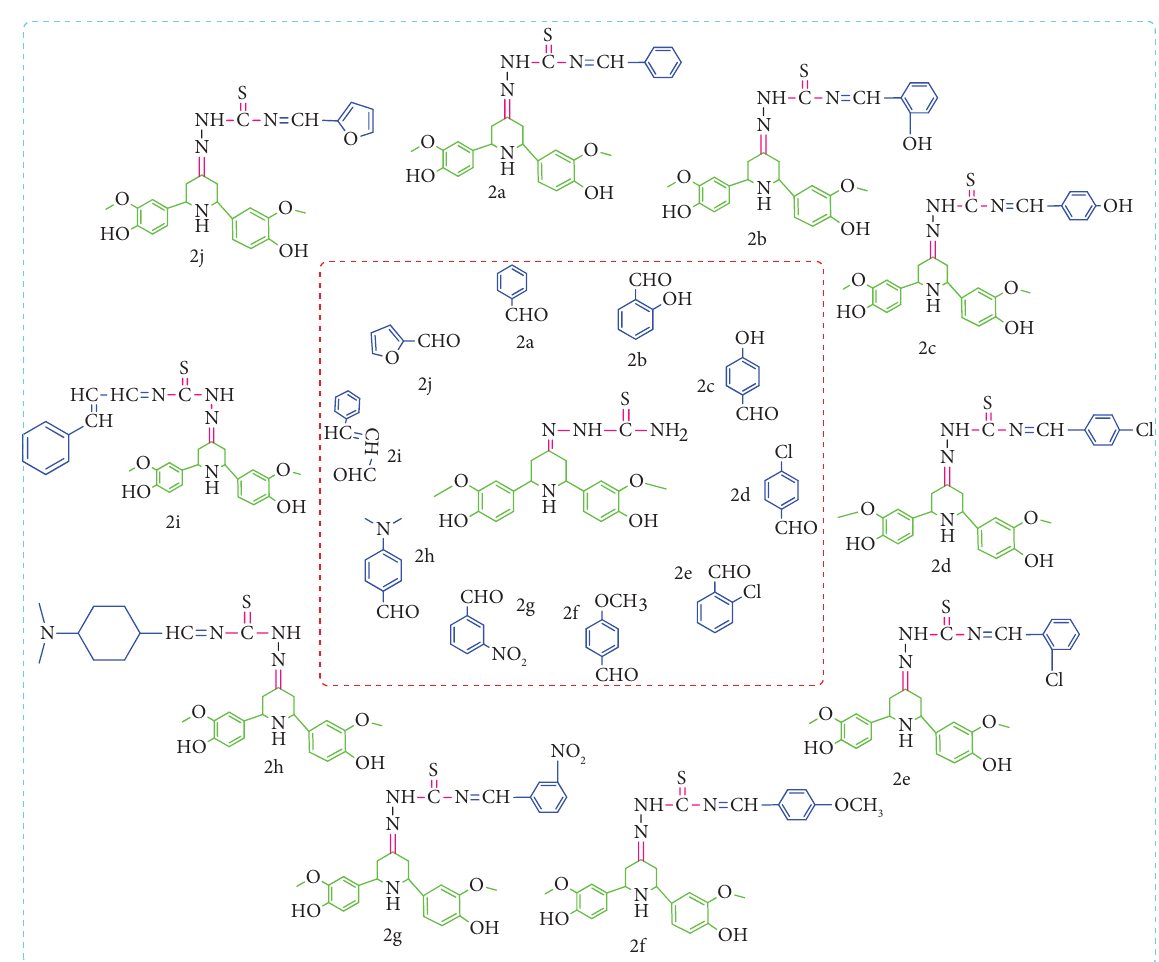
Figure 8: Structure of newly synthesized piperidine-4-ylidene-benzylidene analogues